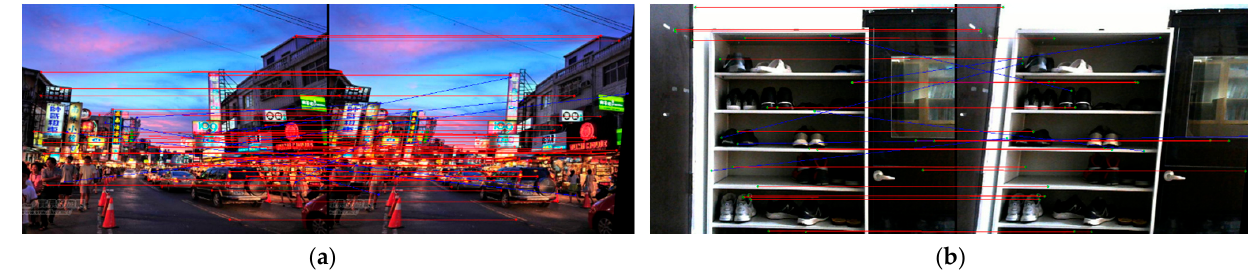
Figure 23. ( a ) Matching accuracy for a skewed outdoor image is 92.39%, where 85 out of 92 feature points are successfully matched; ( b ) Matching accuracy for a skewed indoor image is 88.89%, where 48 out of 54 feature points are successfully matched. Table 4. Performance comparison of proposed E-SIFT with other published papers.